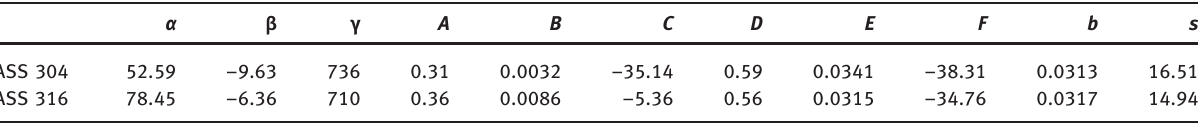
Table 2: Constants obtained for m-FB constitutive model.